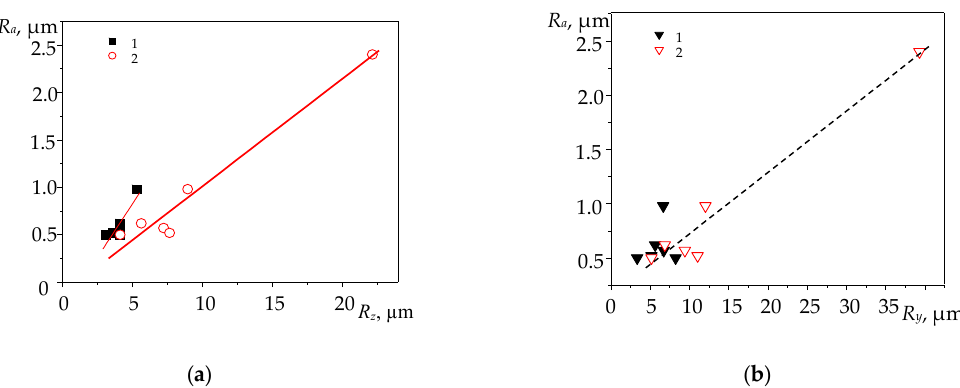
Figure 2. Dependences between roughness parameter of the initial and damaged surface of the specimens from steel 20: ( a ) R a – R z , ( b ) R a – R y ; 1—initial condition; 2—after biocorrosion